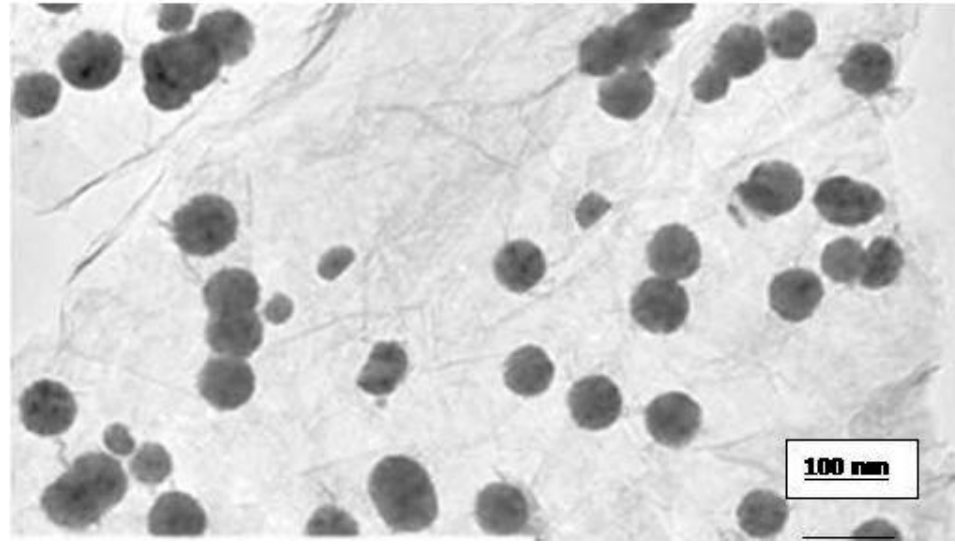
Figure 2. Transmission electron microscope picture of graphene oxide (GO). Diameter size: 38 nm.